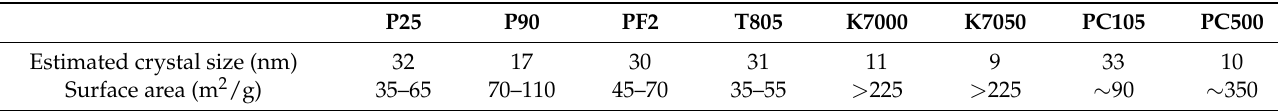
Table 2. Estimated crystal size and the listed surface area for the TiO 2